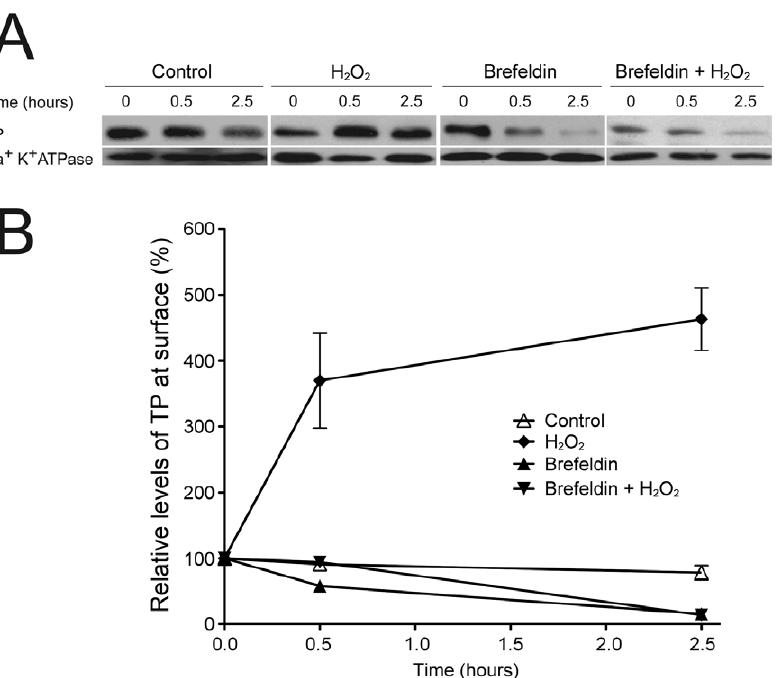
Figure 5. Increased surface expression of TP b is sensitive to brefeldin A. Kinetic analysis of HEK293 cells stably expressing HA-TP b were performed in the absence and presence of brefeldin A. Cultures were treated with cycloheximide (30 m M) and brefeldin A (10 m M) prior to the addition of hydrogen peroxide (10 m M). At times 0, 0.5 and 2.5 hours post hydrogen peroxide exposure, cell-surface proteins were labeled with a water-soluble biotin analogue for 30 minutes on ice and recovered on streptavidin beads. TP b was analysed by immunoblotting with anti-HA monoclonal antibodies. Panels are representative data from three independent experiments where loading was controlled by reprobing membranes with anti-Na + -K + ATPase